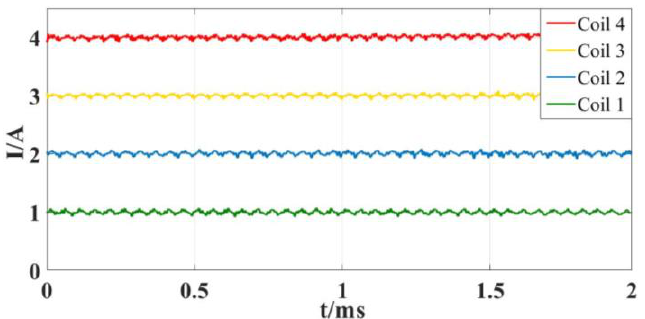
Figure 18. Coil currents driven by half-bridge SPA.